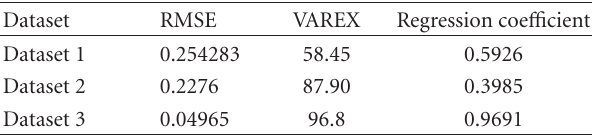
Table 5: Performance Indices for di ff erent datasets using ANN